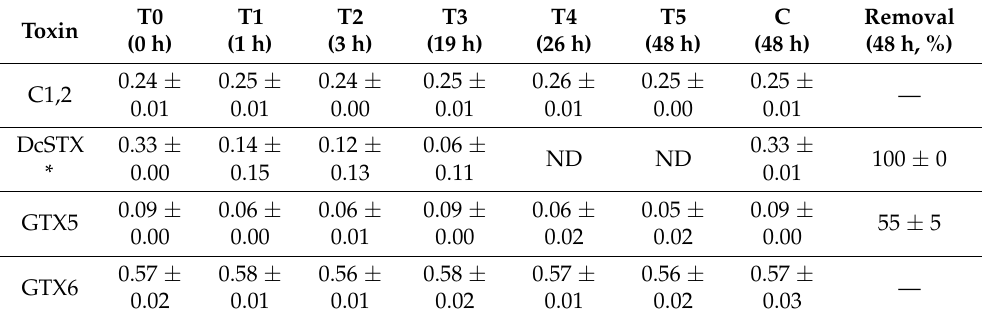
Table 1. PST concentrations, in µ M (average ± standard deviation, SD), in G. catenatum cultures during the removal studies using the H-form resin. At time 0 and 48 h control, no resin was present. T0 T1 T2 Toxin (0 h) (1 h)